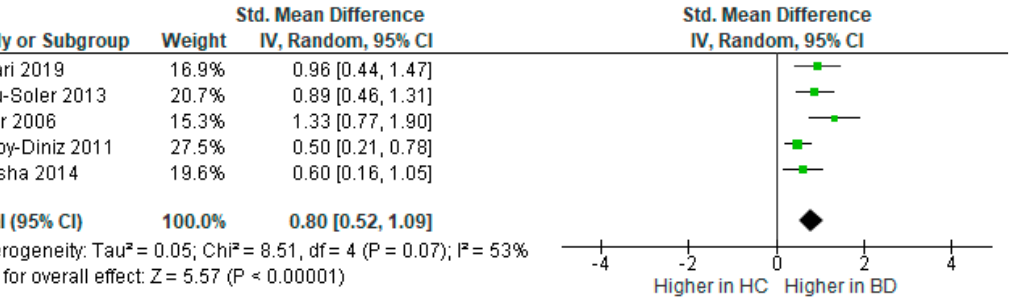
Figure 4. Forest plot of standardised mean differences (SMD) for inattention between bipolar disorder (BD) and healthy controls (HC).